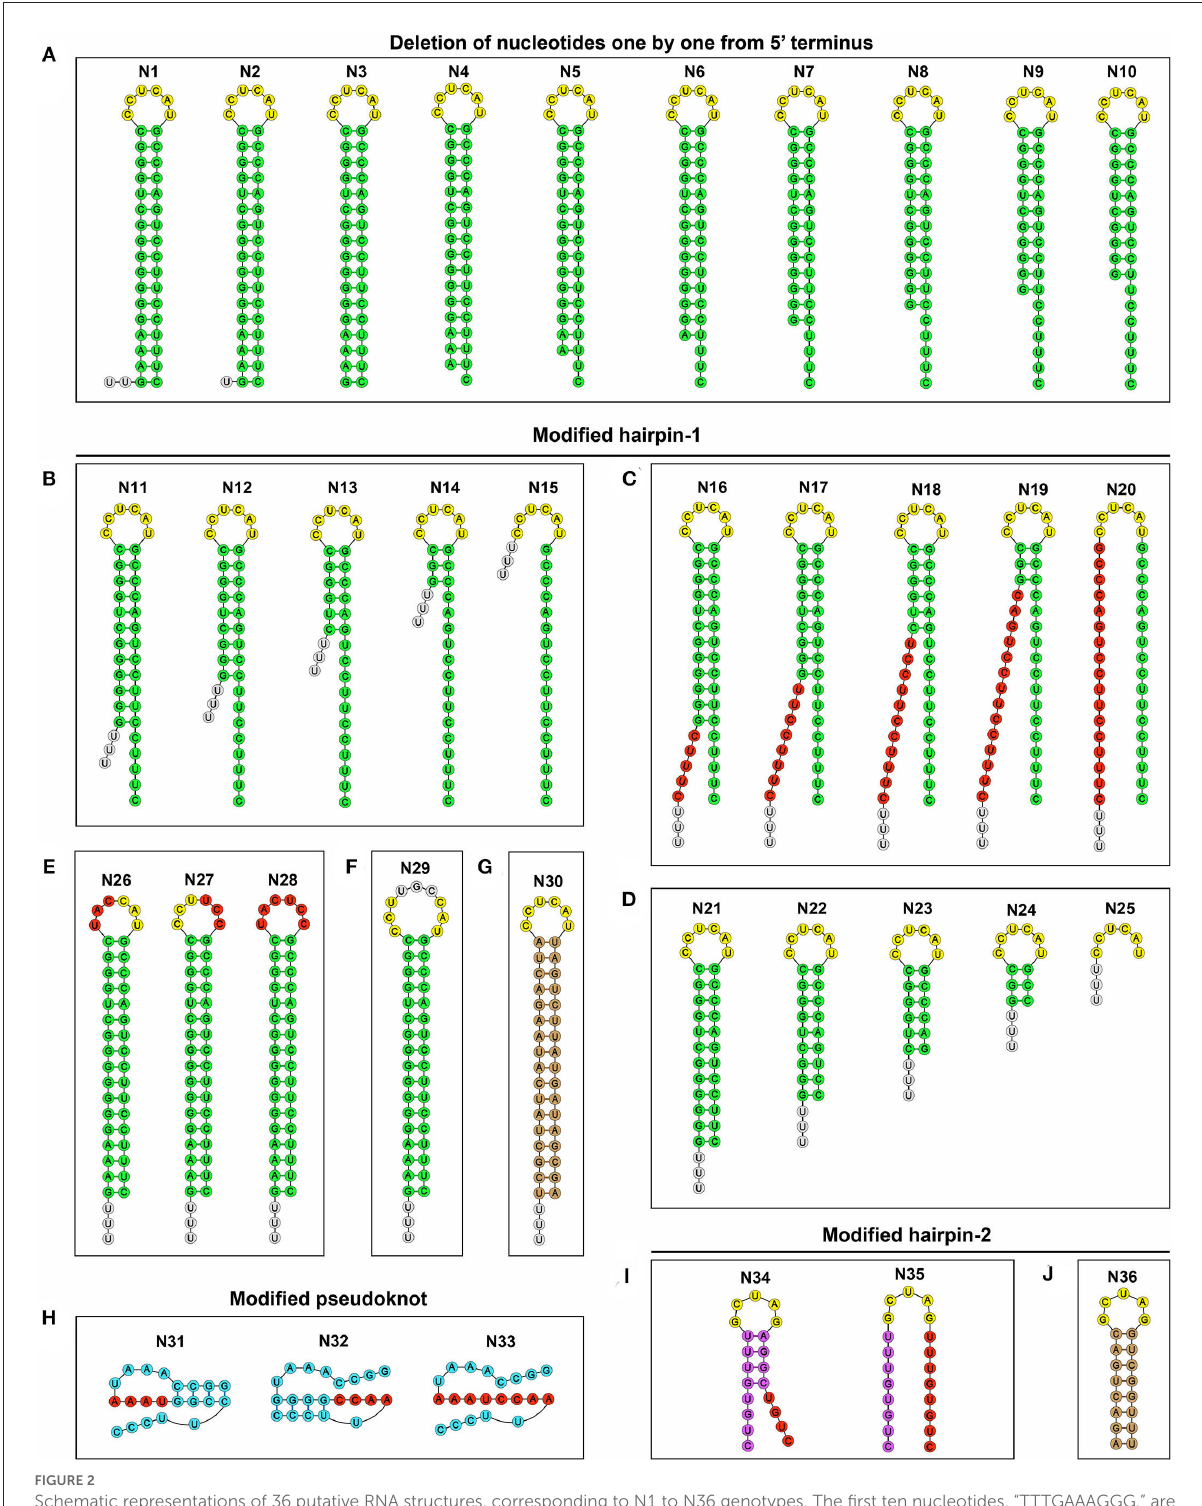
FIGURE2 Schematic representations of 36 putative RNA structures, corresponding to N1 to N36 genotypes. The first ten nucleotides, “TTTGAAAGGG,” are deleted one by one from the N0 to construct N1 to N10 (A) . The HPH-forming motif (nt 4 to 85) in the N0 is genetically modified to construct N11 to N36, including single-stranded deletion (B) , single-stranded mutation [ (C,E,H,I) , Red circle-marked], double-stranded deletion (D) , double-stranded substitution [ (G,J) , Brown circle-marked] and single-stranded insertion [ (F) , Gray